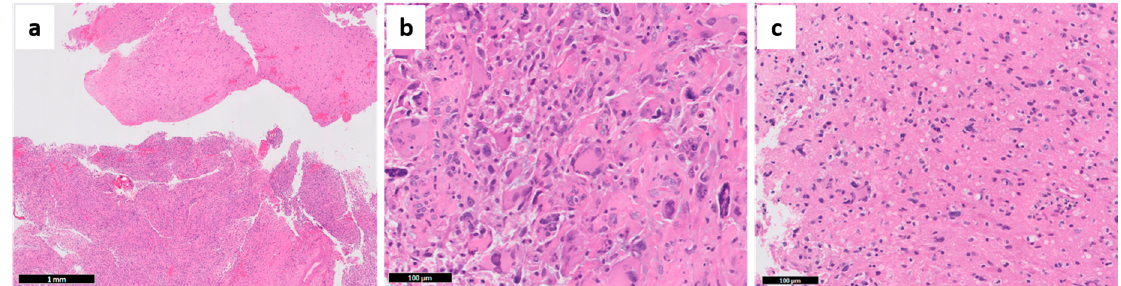
Figure 4. Additional features of glioblastoma. ( a ) Multiple histopathological grades can be seen in the same tumor—in this example, the upper fragments represent lower grade, while the bottom part depicts a fully developed GBM. ( b ) Extensive pleomorphism with giant cells may be seen, but the small cells are the most invasive component. ( c ) Inflammatory cells may invade GBM (same case as Figure 6a). Representative images captured from OSU Tissue